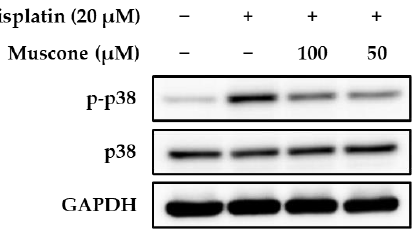
Figure 4. Effect of muscone on phosphorylation of p38 in kidney proximal tubule LLC-PK1 cells. The cells were exposed to indicated doses of muscone in the presence or absence of cisplatin for 24 h. Protein expression was assessed using immunoblotting.